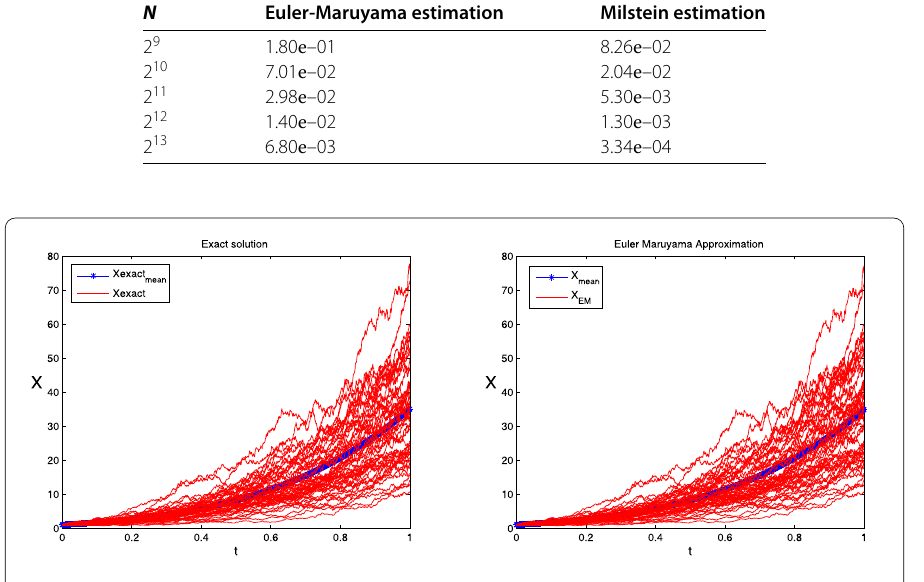
Figure 1 Exact solution and EM simulation averaged over 10,000 discretized sample paths along 50 individual paths for N = 2 10 .